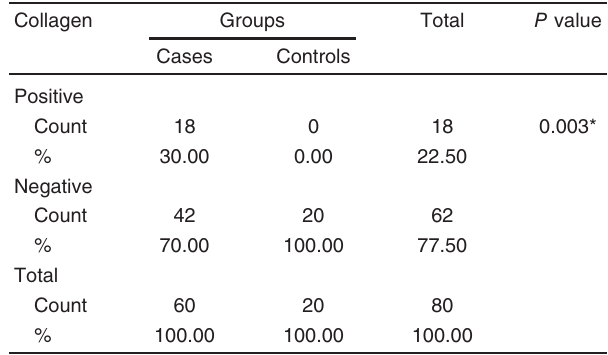
Table 2 Comparison between cases and controls regarding collagen markers Collagen Groups